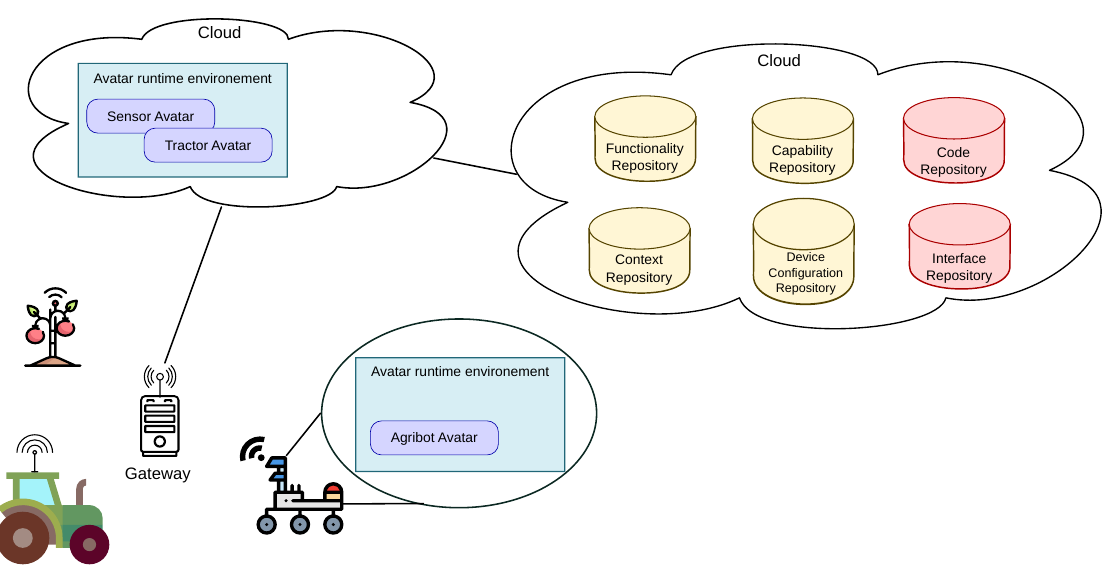
Figure 5. Avatar runtime